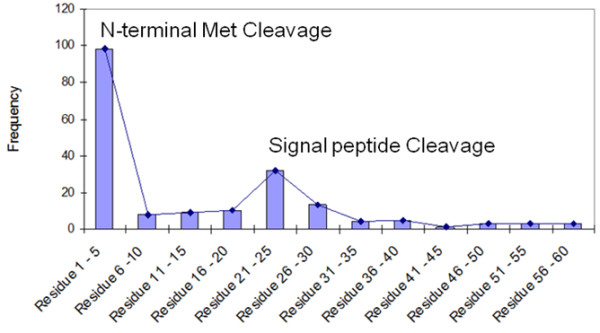
In vivo proteolytic cleavage analysis. Distribution of the curated non-tryptic peptides with residue start positions between 2 and 60 reveals two peaks at residue start positions 1-5 and at residue start positions 21-25 indicative of N-terminal methionine cleavage and cleavage of signal peptides respectively.